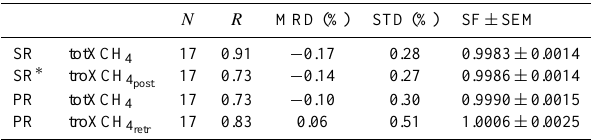
Table 5. Statistics of the daily mean comparisons between the side- by-side measuring instruments 120M and 125HR.